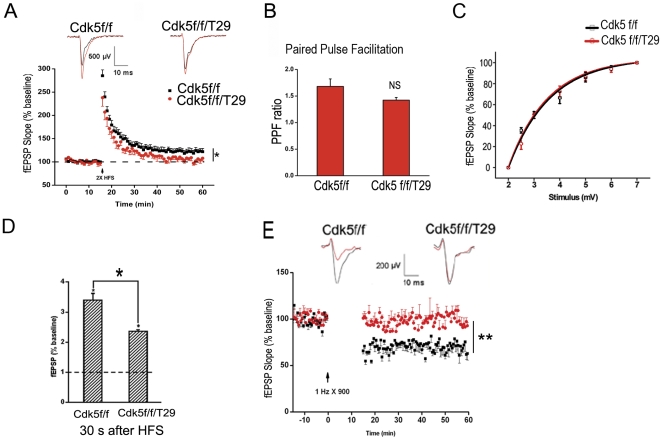
Synaptic plasticity is largely impaired in Cdk5f/f/T29 mice.
A. Acute hippocampal slices obtained from 2-month-old Cdk5f/f/T29 and Cdk5f/f mice were stimulated with two trains of HFS (100 Hz, 1 s) in area CA1. Field EPSPs (fEPSPs) were measured from area CA1 in Cdk5f/f and Cdk5f/f/T29 mice (n = 8 for each group). B. Paired-pulse facilitation (PPF) in Cdk5f/f mice and Cdk5f/f/T29 and (n = 9 for each group). C. The input-output curve indicates normal basal synaptic transmission in the Cdk5f/f/T29 mice. D. Post-tetanic potentiation (PTP) from Cdk5f/f/T29 mice was lower than in Cdk5f/f mice 30 s after two trains of HFS (100 Hz, 1 s). E. LTD was measured in area CA1 of acute hippocampal slices from Cdk5f/f and Cdk5f/f/T29 after low frequency stimulation (1 Hz, 900 pulse; n = 6 for each group).